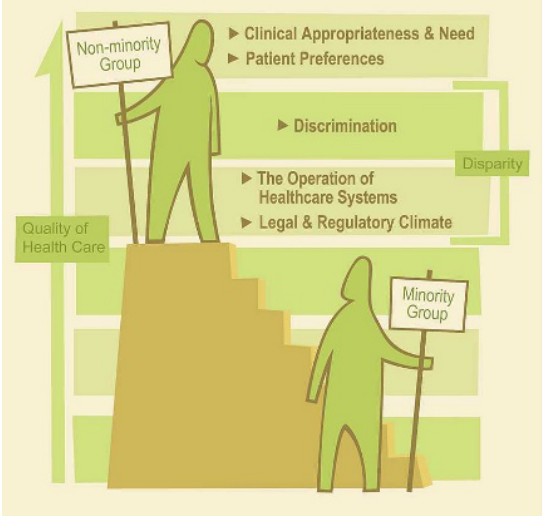
Figure 1. Minority Groups Face a Disparity in the Quality of Health Care (Illustration: Giovanni Maki, adapted from [2]). The Institute of Medicine defi ned “disparities” in health care as racial or ethnic differences in the quality of health care that are not due to access-related factors, clinical needs, patient preferences, or appropriateness of intervention